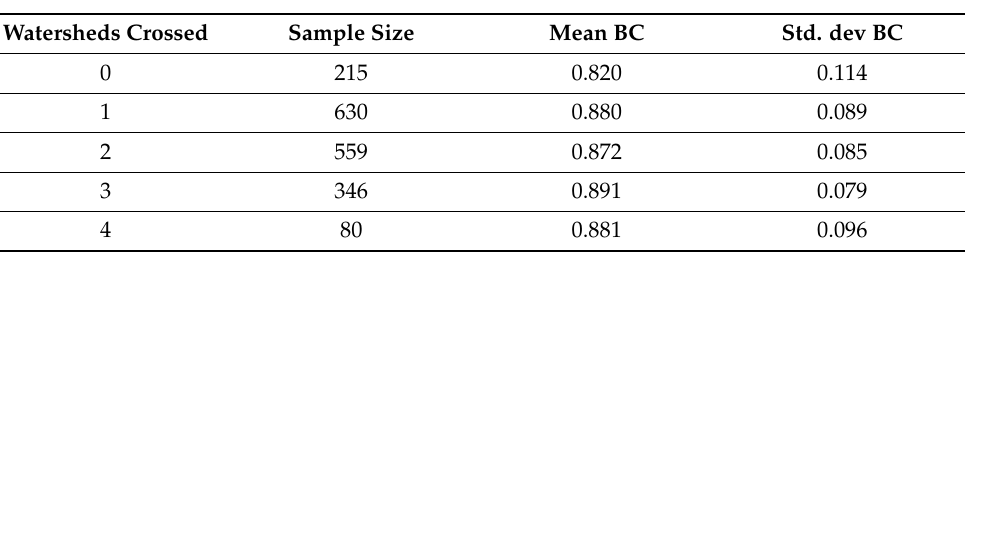
Figure 3. Binning of community turnover into watershed crossings (“hops”). Red points represent Bray–Curtis dissimilarities between tree communities among all 61 sites with increasing watershed crossings between sites. Table 2. Mean dissimilarity (Bray-Curtis dissimilarity) of survey sites by number of watersheds crossed.